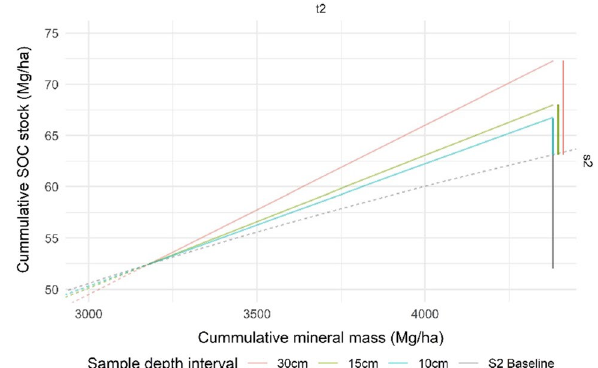
Figure 5. Corrected cumulative SOC stock (> 50 Mg ha −1 ) per cumulative mineral mass (> 3000 Mg ha −1 ) for scenario 2 at time point t2 for sample depth intervals 10 cm, 15 cm, and 30 cm (scenarios 2a, 2b, and 2c, respectively) compared to the scenario 2 baseline profile, showing vertical error bars due to no correction with changing bulk density. The error is the difference in the corrected SOC stock from the global average soil at the same mineral mass. Sampled data are solid and corrected data are dashed as for Fig. 4.